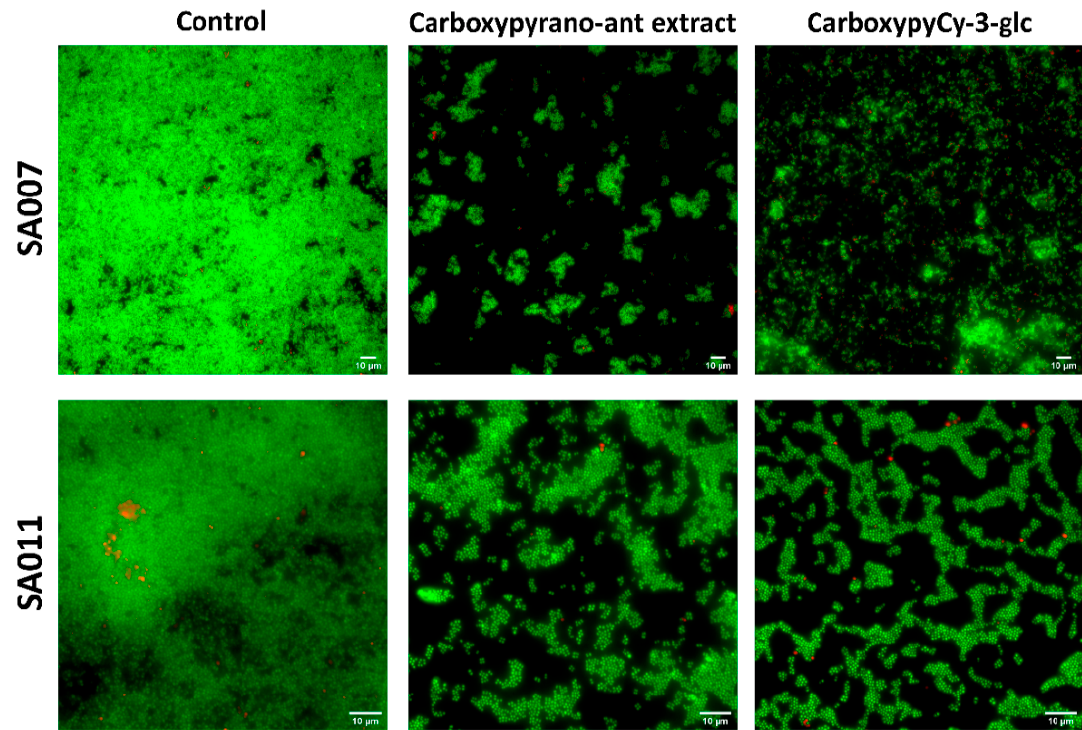
Figure 3. Fluorescence microscopy representative images, after Live/Dead staining, of SA007 and SA011 biofilms formed for 24 h in absence (control) and presence of carboxypyrano-ant extract or carboxypyCy-3-glc, at 64 µ g/mL. Scale bar: 10 µ m.